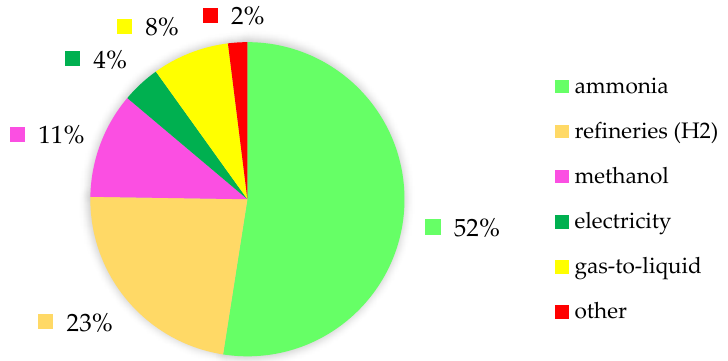
Figure 2. End uses of syngas, totally ~6 EJ/y [35].